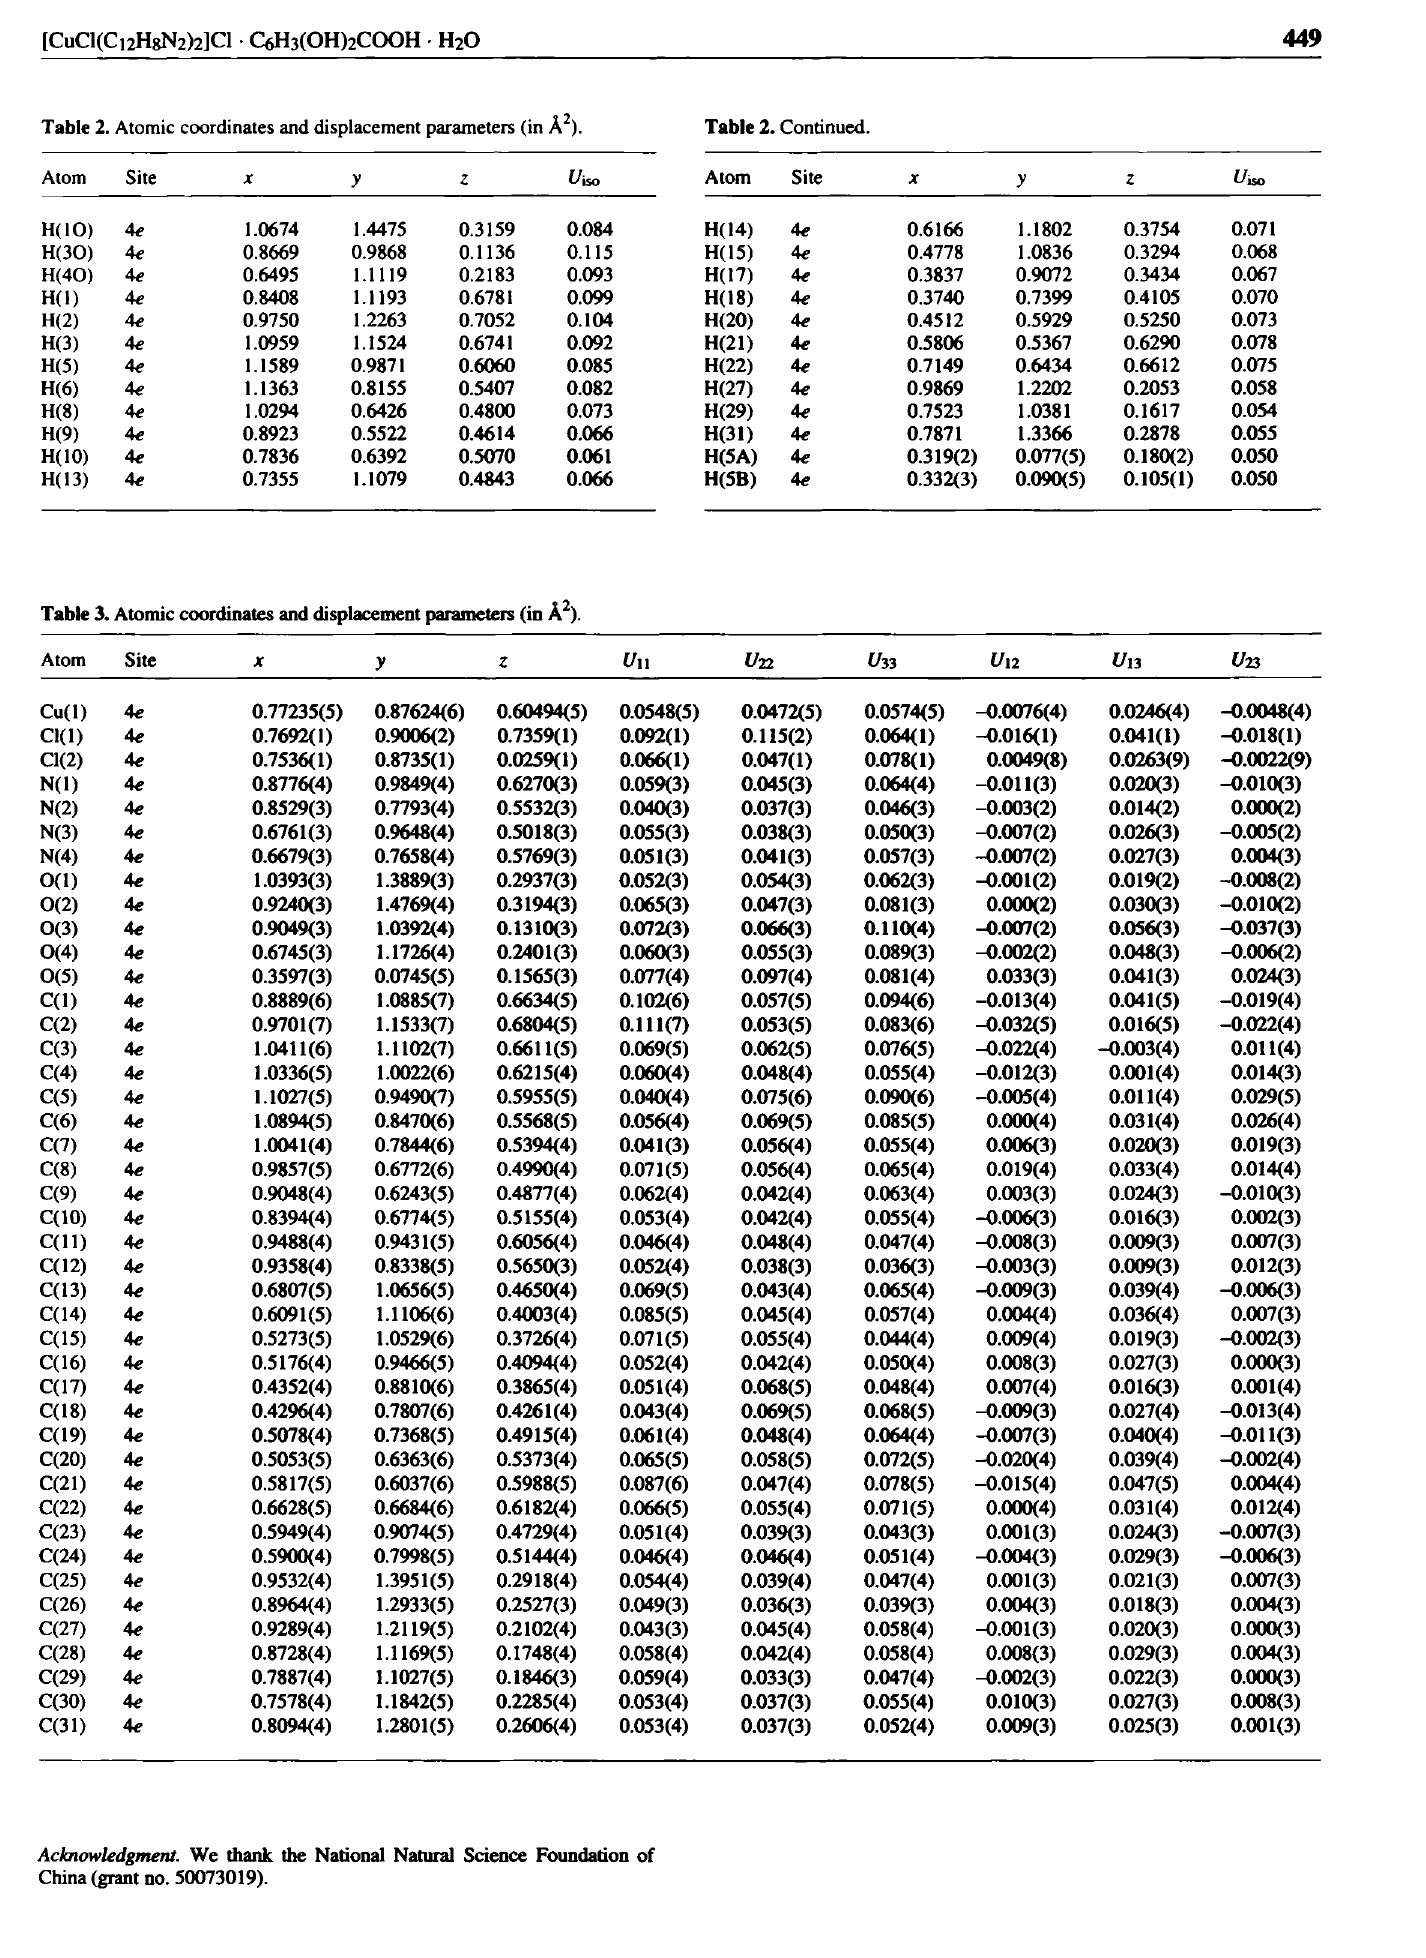
Table 2. Atomic coordinates and displacement parameters (in A 2 ).